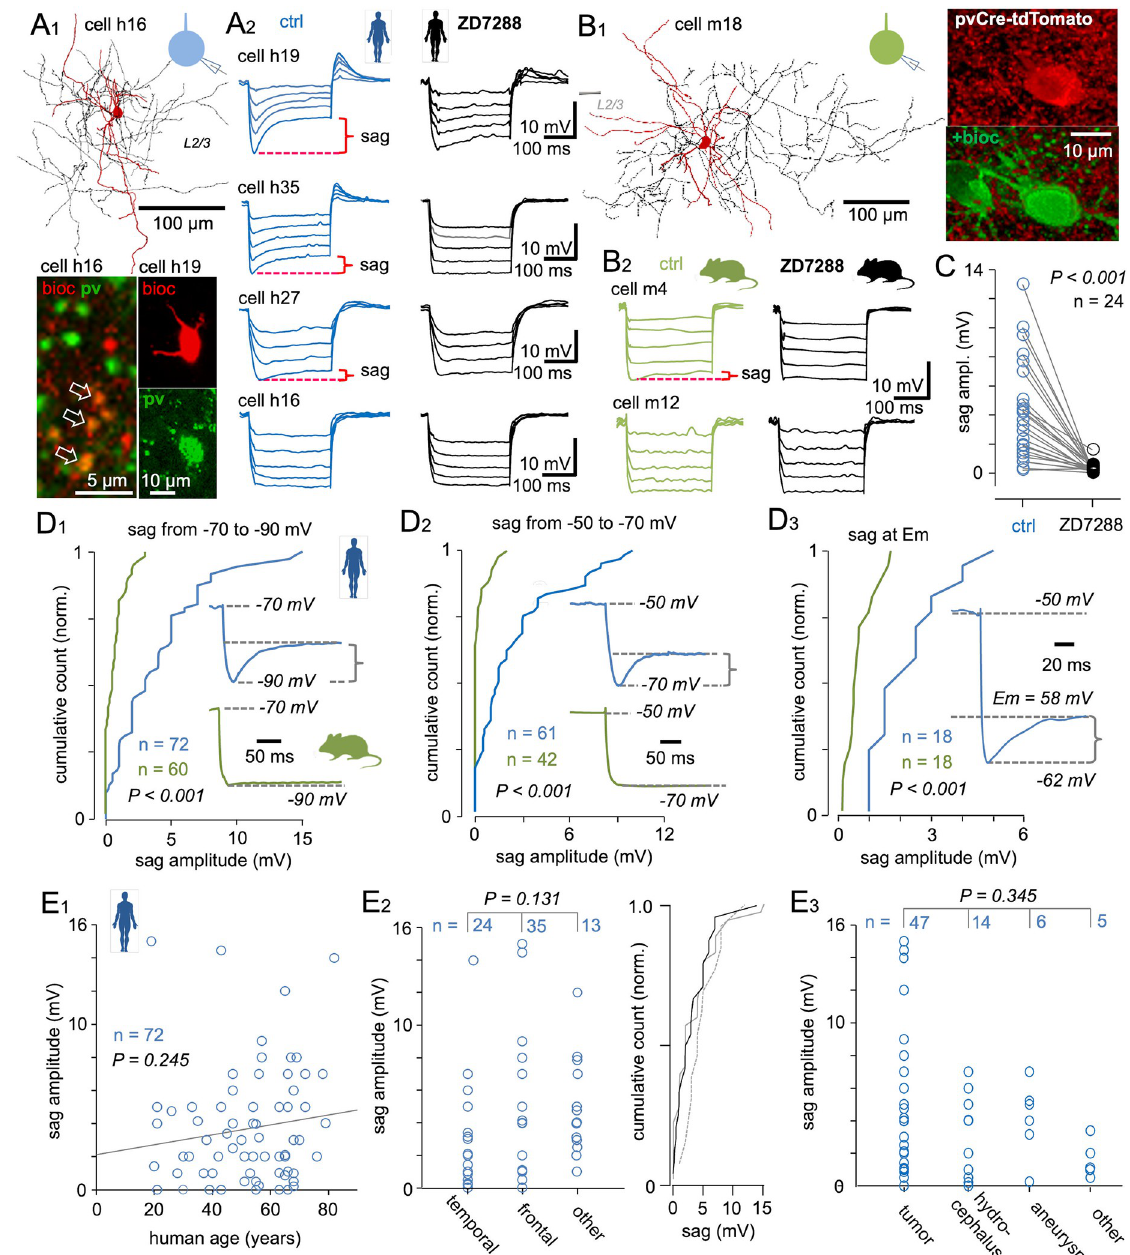
Fig 1. Human but not mouse fast-spiking basket cells exhibit a robust somatic HCN channel-mediated sag potential. ( A ) Somatic sag potentials recorded from human fast-spiking pv interneurons. ( A1 ) Anatomical and immunohistochemical illustrations of human fast- spiking pv-immunopositive basket cells filled with biocytin during whole-cell recording from the soma. (Inset schematics shows whole-cell clamp protocol.) Top: Partial anatomical reconstruction showing the soma and dendrites (red) and axon (black) of cell h16 (visualized in two 60- μ m thick merged sections). L2/3: neocortical layer 2–3. Bottom: Confocal images showing pv immunofluorescence in a bioc-filled neuronal axon (cell h16, pv, and bioc merged, costained axon boutons indicated by arrows) and a neuronal soma (cell h19). ( A2 ) Human fast-spiking basket cell membrane potential responses to hyperpolarizing square-pulse current steps delivered from − 70 mV. Traces reaching a peak hyperpolarized potential of − 90 mV illustrate the hyperpolarization-activated sag potential in three of four sample neurons under control conditions (blue traces). Sample recordings show cell h19 with large sag, cells h35 and h27 with close to median-sized sag, and a cell without sag (cell h16). Black traces show responses of these same cells in the presence of the HCN channel blocker ZD7288 (ZD, 10 μ M). Red markings indicate the ZD-sensitive sag potential amplitude (sag) measured during a hyperpolarizing step from − 70 mV to − 90 mV. ( B ) Absence of robust somatic sag potential in mouse fast-spiking interneurons. ( B1 ) Left: Partial reconstruction of a mouse fast-spiking pv- expressing cell filled with bioc during whole-cell recording (inset schematic shows whole-cell clamp protocol). Right: Same cell (m18) with